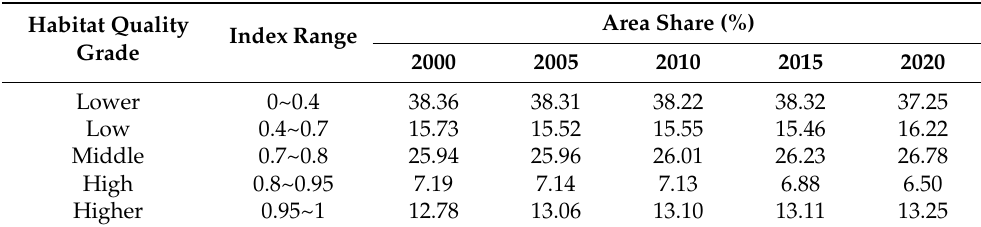
Table 10. Changes in habitat quality grades in the Yellow River Basin in 2000, 2005, 2010, 2015,